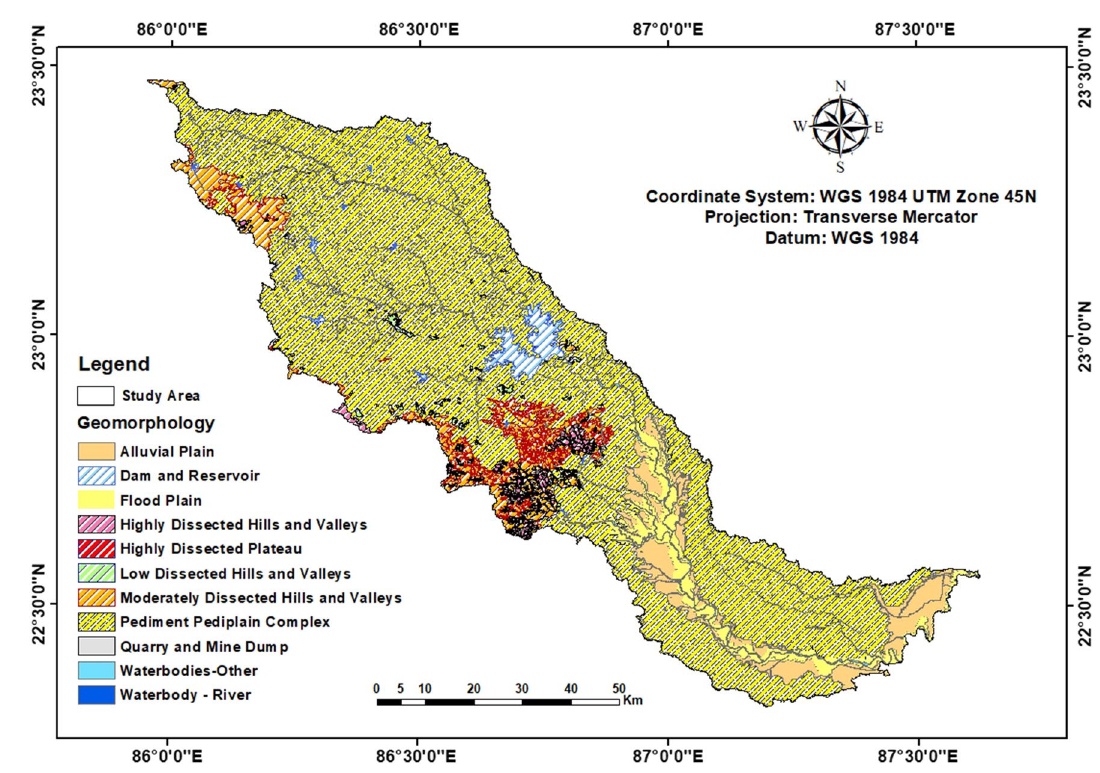
Fig. 5 Spatial map of geomorphology showing different land features of Kangsabati River